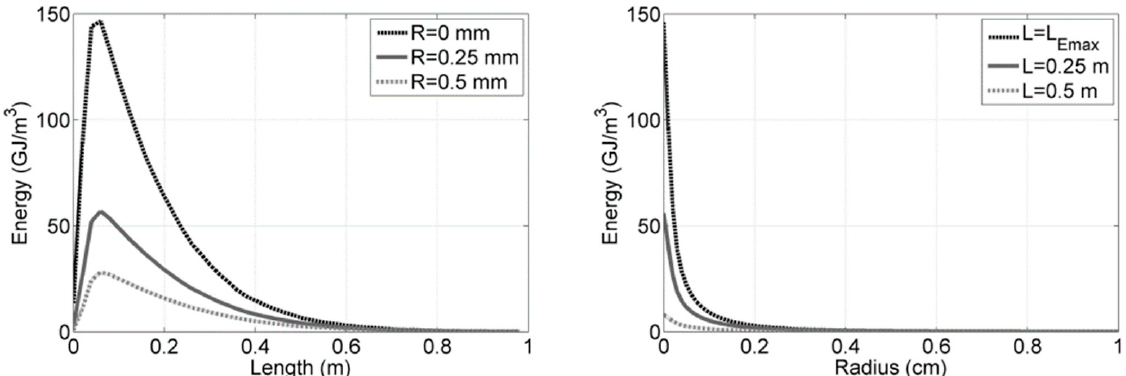
Figure 7. Distribution of the specific energy deposited from a single bunch on tungsten cylindrical bar (result of the FLUKA calculation): energy as a function of the axial direction curves varying the radial coordinate ( left ) and energy as a function of the radial coordinate varying the axial coordinates ( right ).